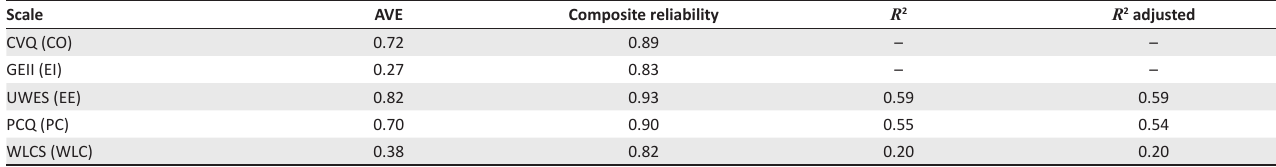
FIGURE 2: Partial least squares report for the personal resources and employee engagement structural TABLE 5: Evaluation of the partial least square inner model and outer model. Scale AVE